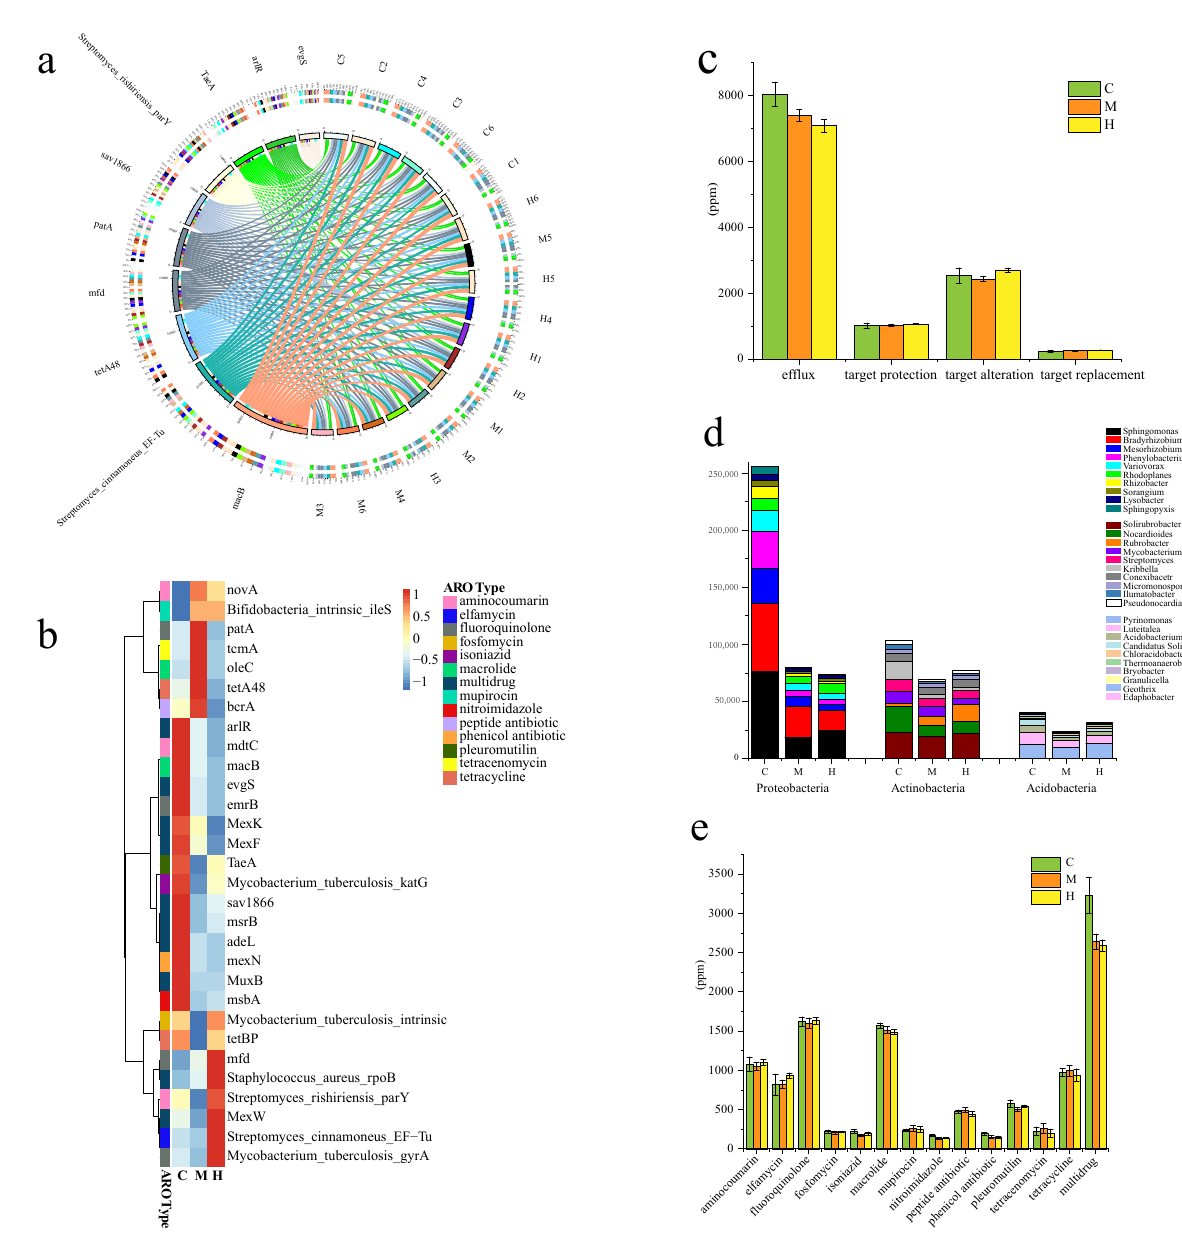
Figure 6. ( a ) The bar width of the bars between ARG types and samples correlates to the percentages of respective ARGs in these samples (in ppm). The different colors in the circle represent different samples and ARGs. ( b ) Heat map analysis of the top 30 most abundant ARGs in at least one group sample using normalized abundance and color-coded based on row z-scores. ( c ) Histogram of four resistance mechanisms of ARGs between groups. ( d ) Histogram of ARGs species attribution analysis. Different colors represent corresponding genera under three phyla. ( e ) Abundance statistics of the top 30 abundant ARGs-related